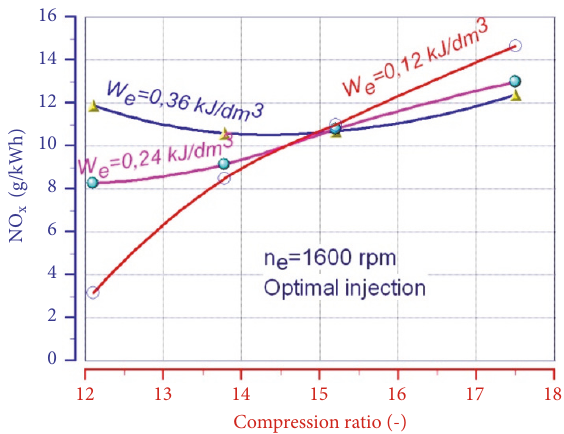
Figure 10: Influence of the (CR) on NO